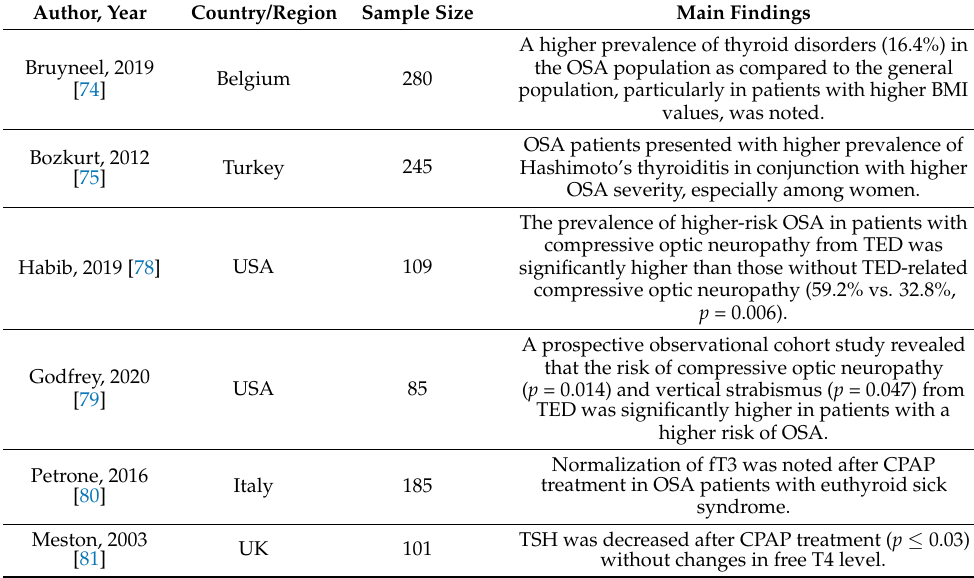
Table A3. Summary of the major studies evaluating the association between OSA and